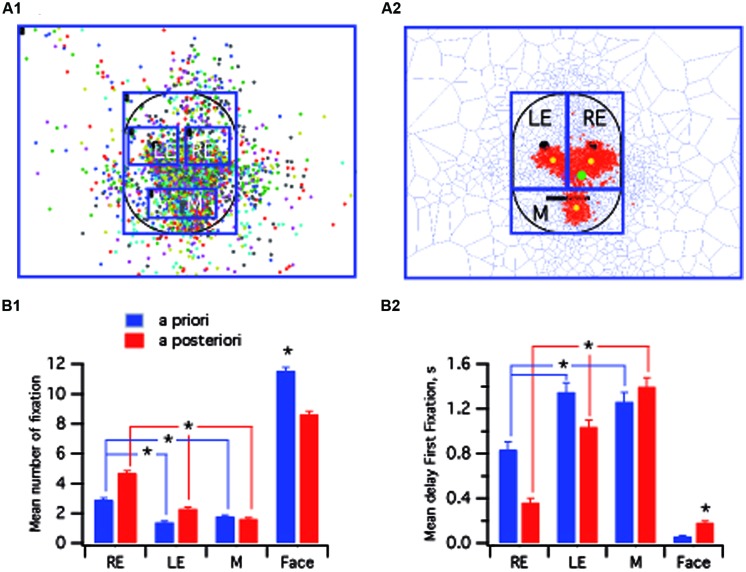
Comparison between a priori and a posteriori methods. (A,A1) Prototypic face with superimposed fixations performed by tested typical adults (N = 13 subjects) for all neutral non-familiar faces (N = 22 presented faces). Each colored dot corresponds to one subject. The regions of interests (ROIs) were centered on core features (eyes, mouth). (A2) From the pattern of superimposed fixations presented in (A1), statistically significant clusters of fixation (red tiles) were detected using Dirichlet tessellation. Large ROIs, not centered on core features (see yellow spots) were circumscribed. (B) Bar graphs presenting the mean number of fixations (B1) and the mean delay to the first fixation (B2) per subject in the four ROIs. M, mouth; LE, left eye; RE, right eye. ∗ indicates a significant variation.